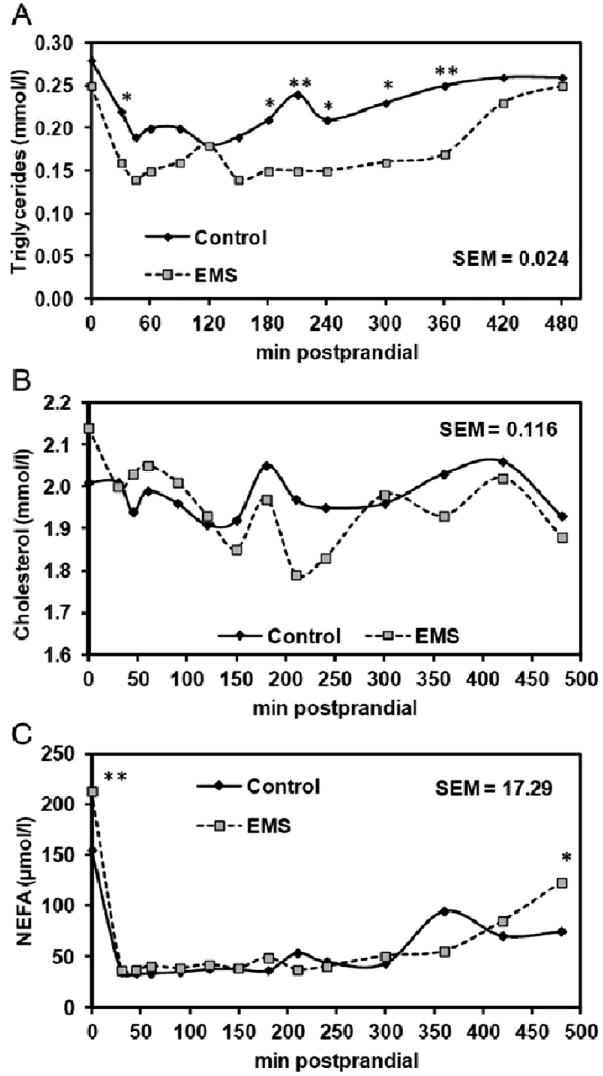
Fig 2. Serum concentrations of triglycerides (A), cholesterol (B), and non-esterified fatty acids (NEFA) (C) during the meal tolerance test in pigs fed the enzymatically modified starch (EMS) diet or control diet. Results are presented as least-squares means ± SEM (control diet, n = 7; EMS diet, n = 6). EMS diet versus control diet, * P < 0.10, ** P < 0.05.